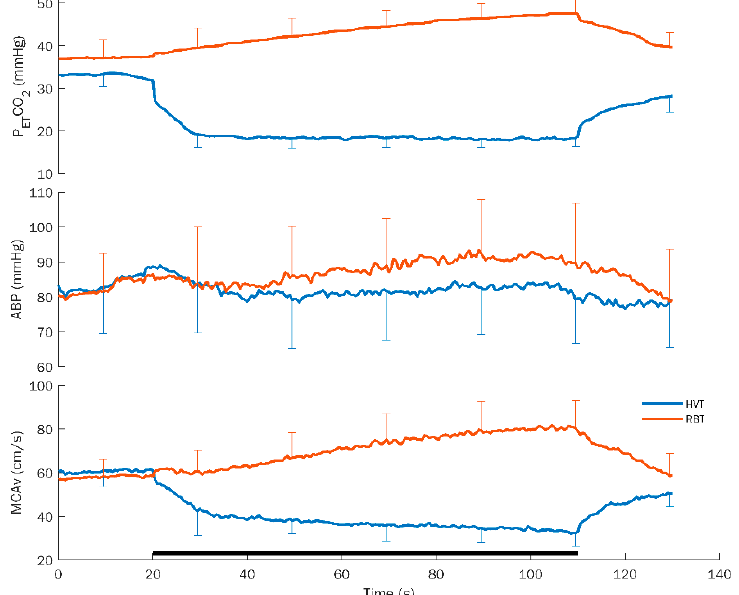
Figure 1. Average response curves for hyperventilation (HVT) and rebreathing (RBT) with standard deviation for the different variables. P ET CO 2 : partial pressure of end-tidal CO 2 ; ABP: arterial blood pressure; and MCAv: middle cerebral artery flow velocity. The black bar at the bottom indicates the duration of the task. Note the opposite effects on each variable exhibited by the HVT and